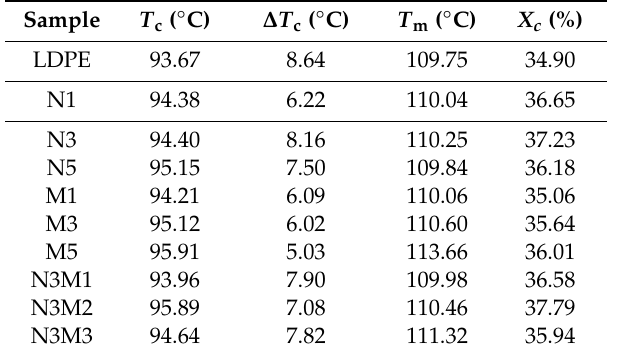
Isothermal crystallization and melting process parameters of micro, nano and micro-nano-ZnO / LDPE and LDPE